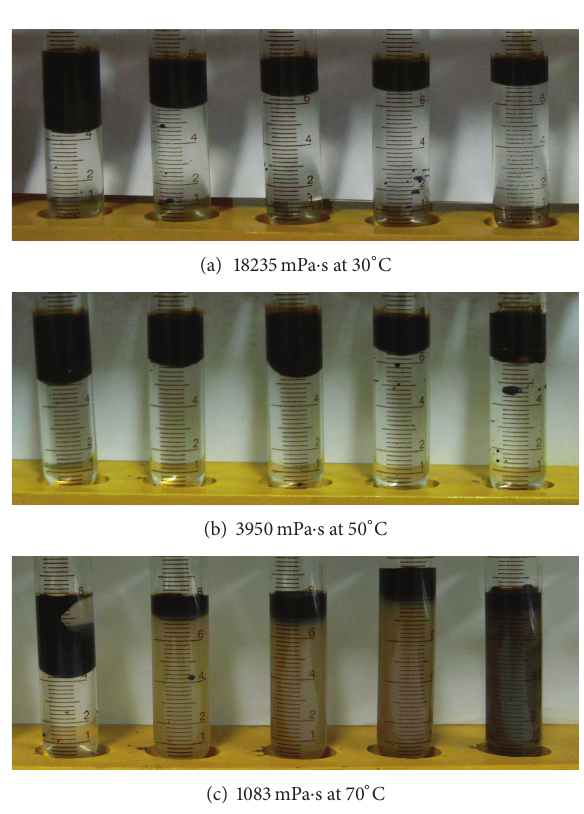
Figure 8: Pictures of the fluid produced during the displacement tests of Xia-8 heavy oil with different viscosities. (Effluents during alkaliinjectionandtheextendedwaterfloodingwerecollectedinthe tubes from left to right in turn. The pictures show their appearances at the end of flooding, without